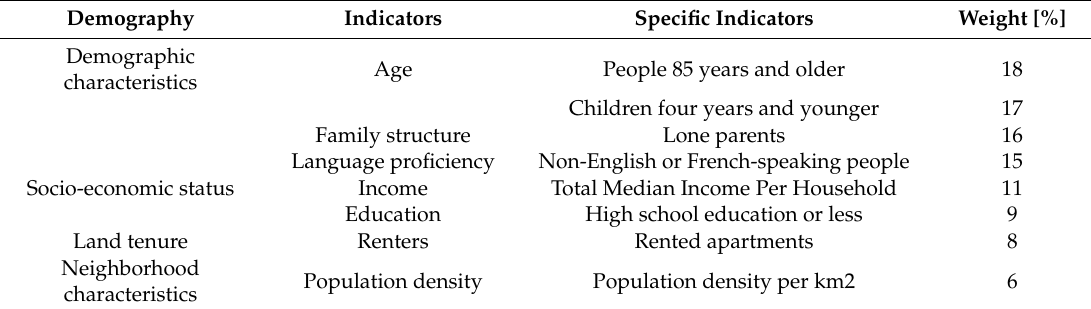
Table 2. Criteria used for social